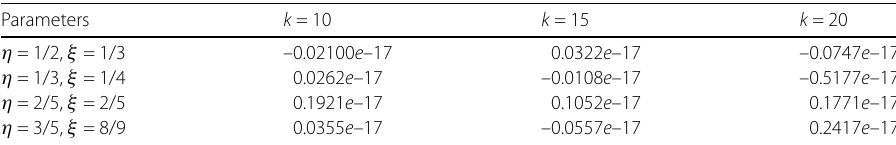
Table 3 Absolute error in boundary conditions of u ( t ) of Example 6.2 using different choice of parameters Parameters k = 10